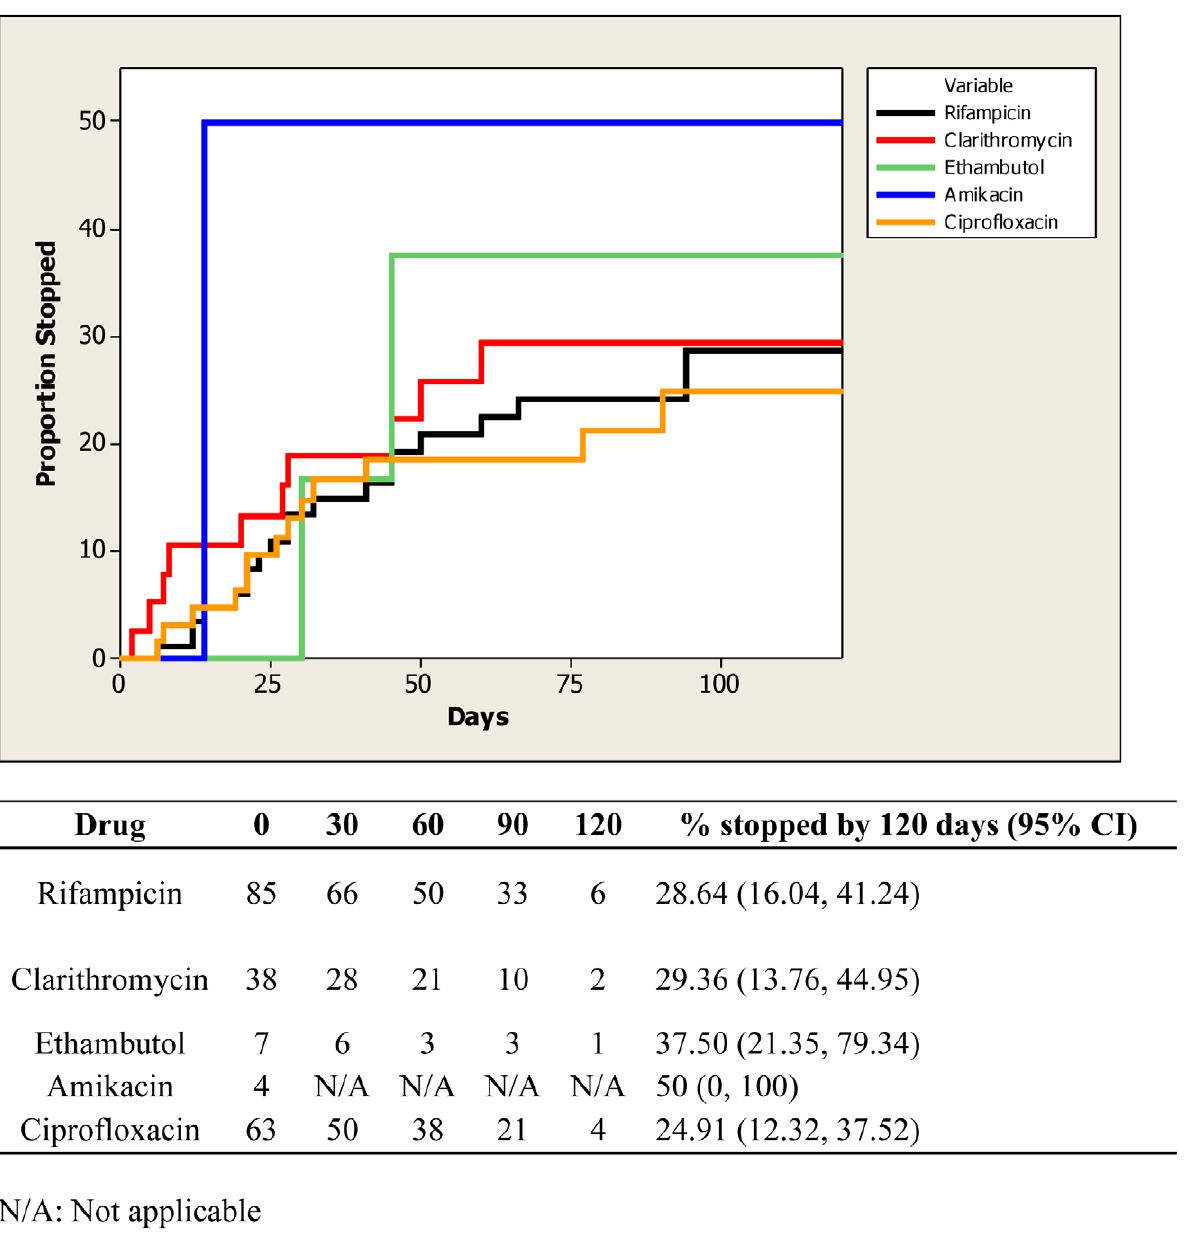
Figure 2. Proportion of individual antibiotics ceased over time due to complications.